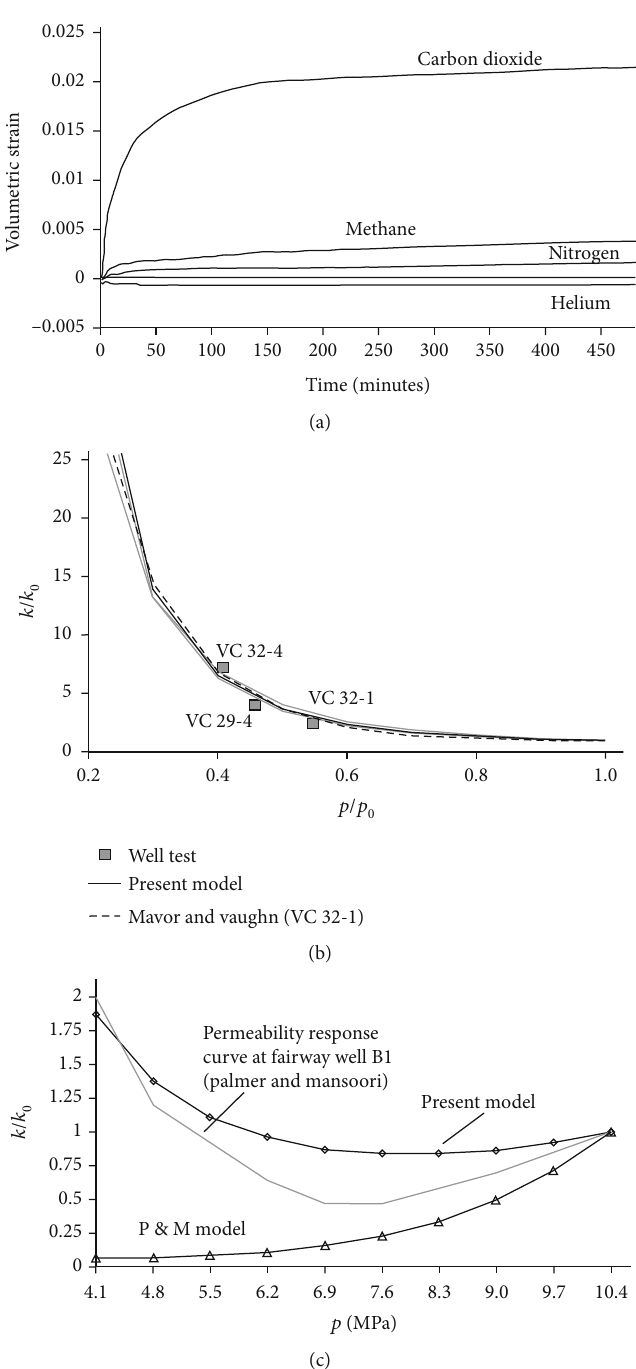
Figure 23: (a) Volumetric strain associated with gas adsorption at 4MPa. (b) Comparison between the simulation results of the permeability model and well test data. (c) Permeability response curves of di ff erent permeability models. (Modi fi ed from St George and Barakat [23] and Shi and Durucan